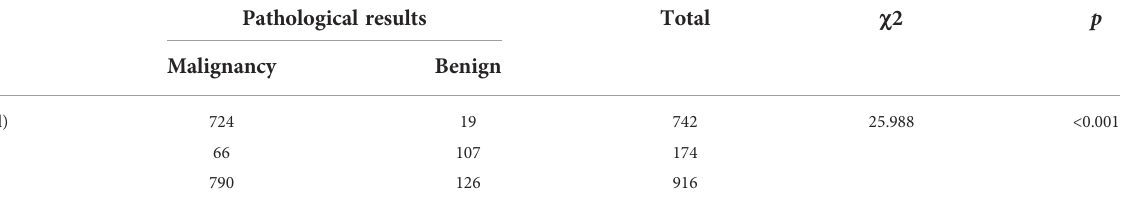
TABLE 3 NBI video bronchoscopy comparison with pathological